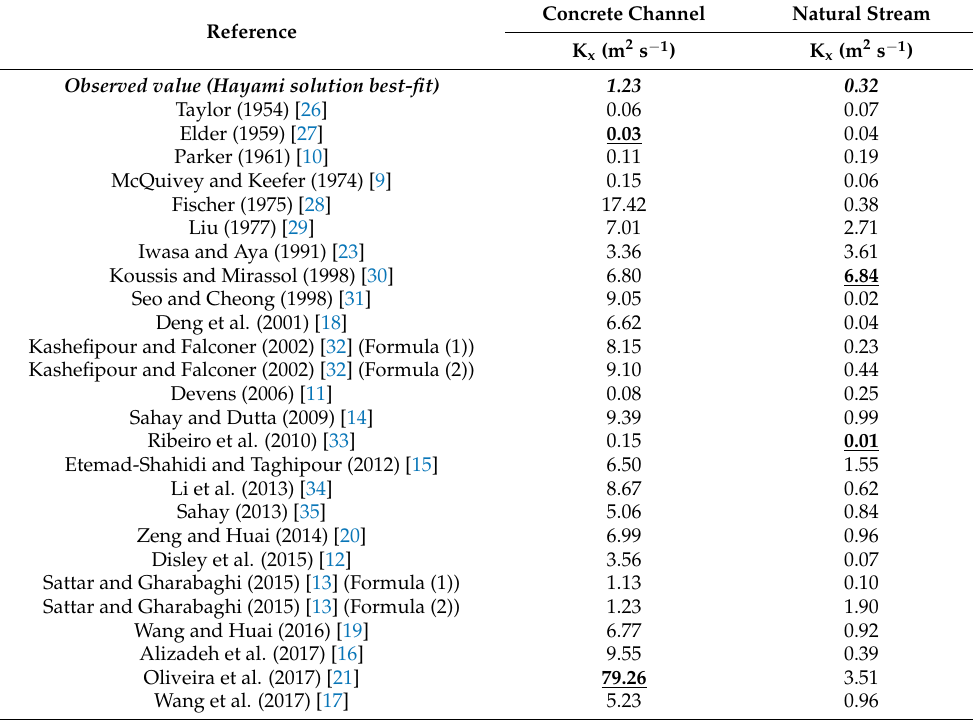
Table 4. Longitudinal dispersion coefficients for the concrete channel and natural stream estimated from the 26 predictive formulae (presented here in chronological order) in comparison to the observed value (top line, italics). The largest and smallest values are underlined and in bold